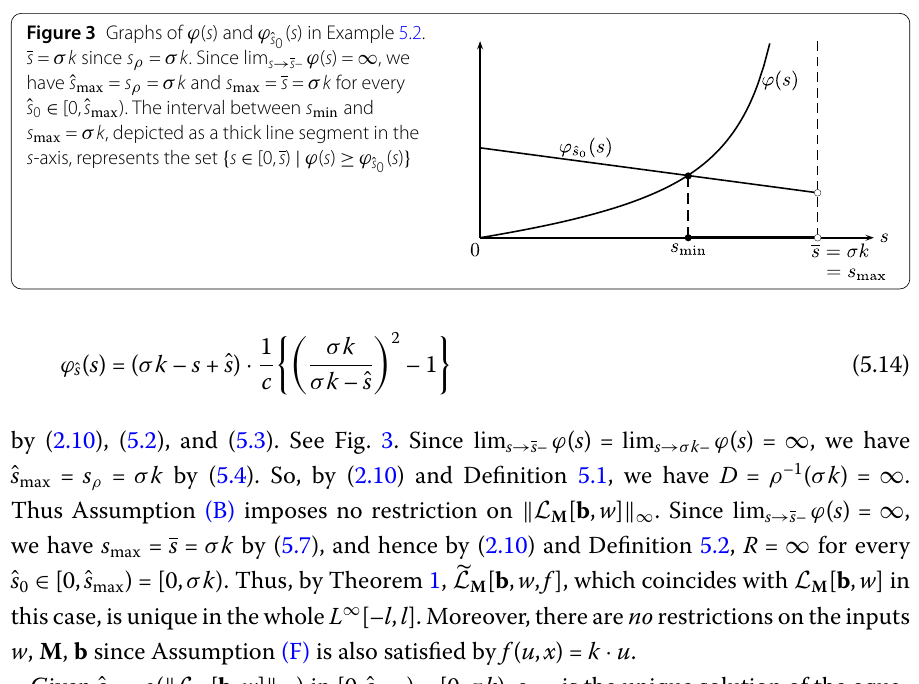
Figure 3 Graphs of ϕ ( s ) and ϕ ˆ s s = σ k since s ρ = σ k . Since lim s → s – ϕ ( s ) = ∞ , we have ˆ s max = s ρ = σ k and s max = s = σ k for every ˆ s ∈ [0, ˆ s 0 max ). The interval between s min and